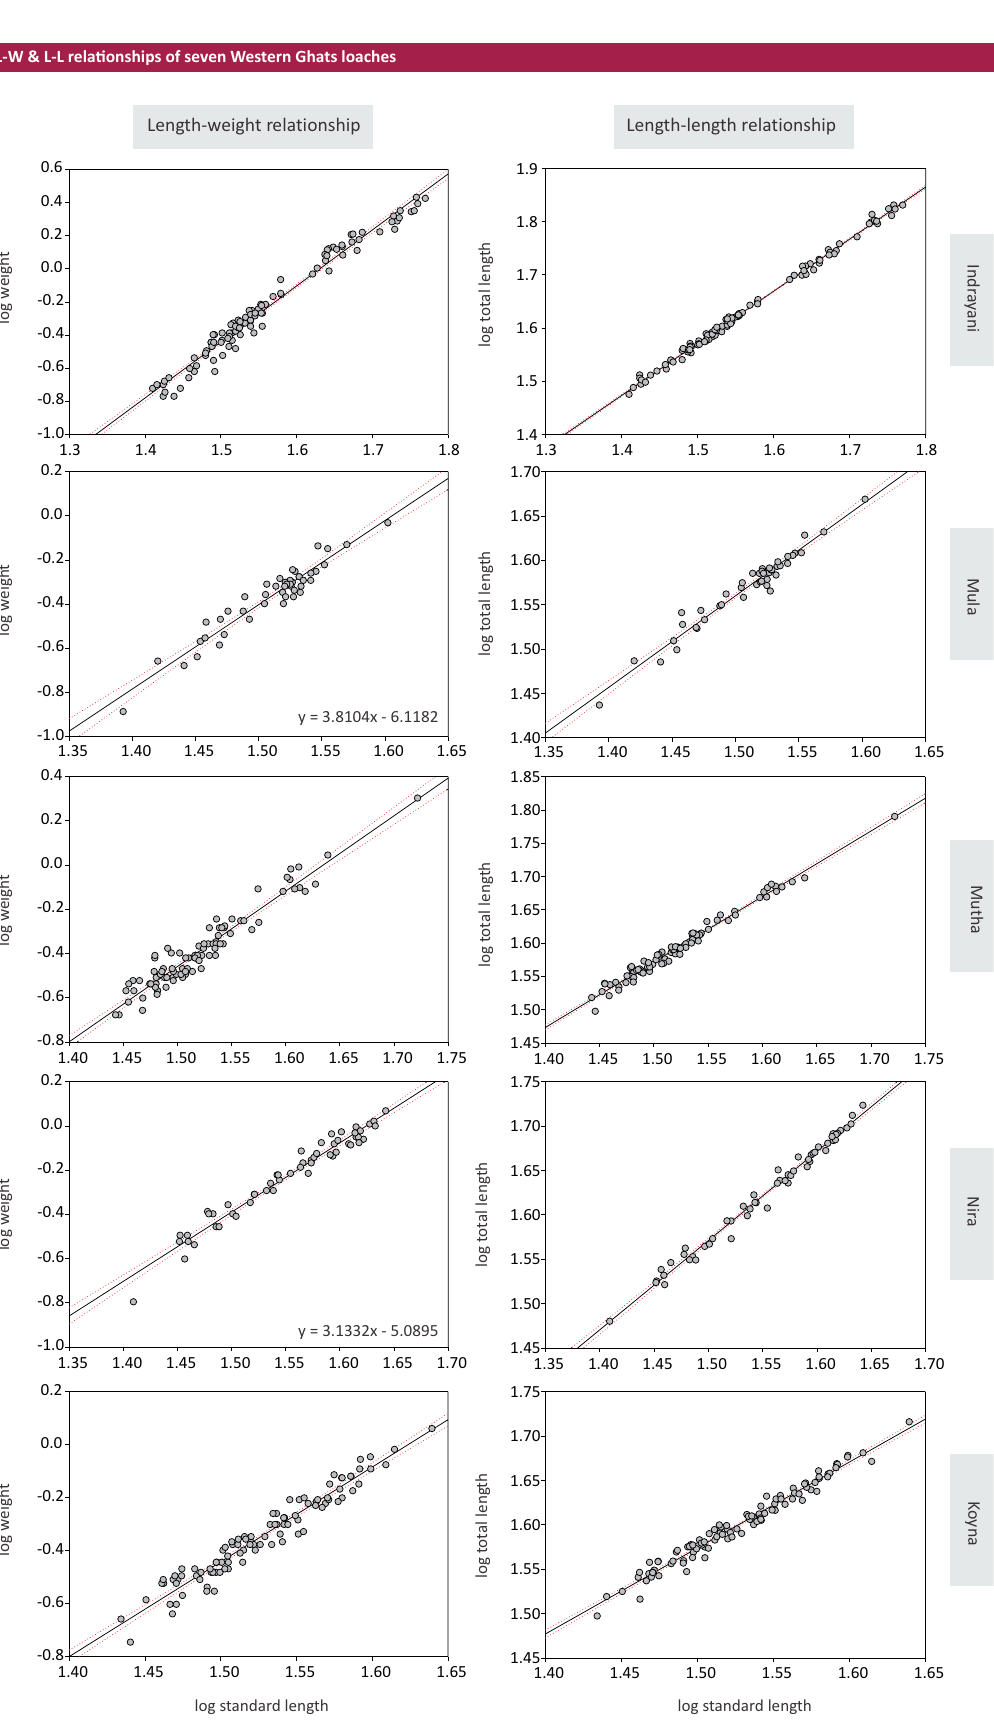
Appendix B. Scatter plots for Lepidocephalichthys thermalis . Dashed lines are 95% confidence intervals for the regression